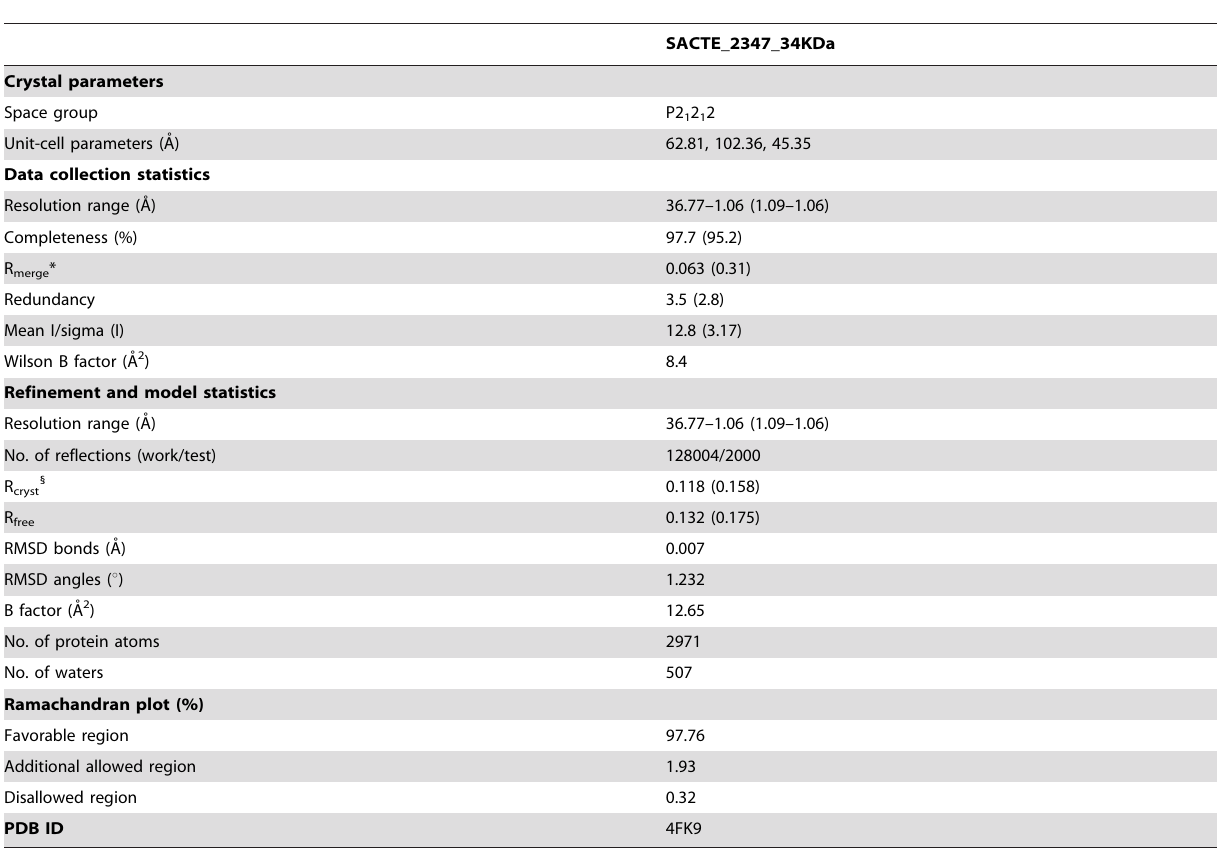
Table 2. Summary of crystal parameters, data collection, and refinement statistics.